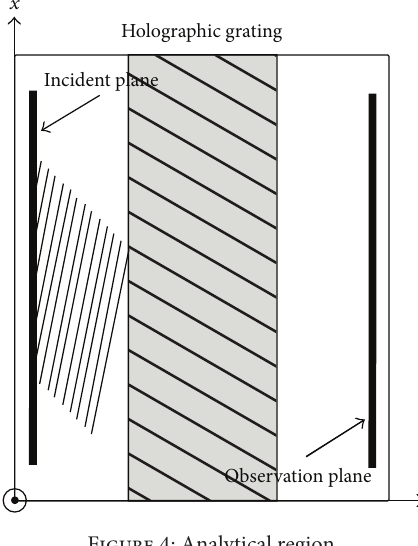
Figure 4: Analytical